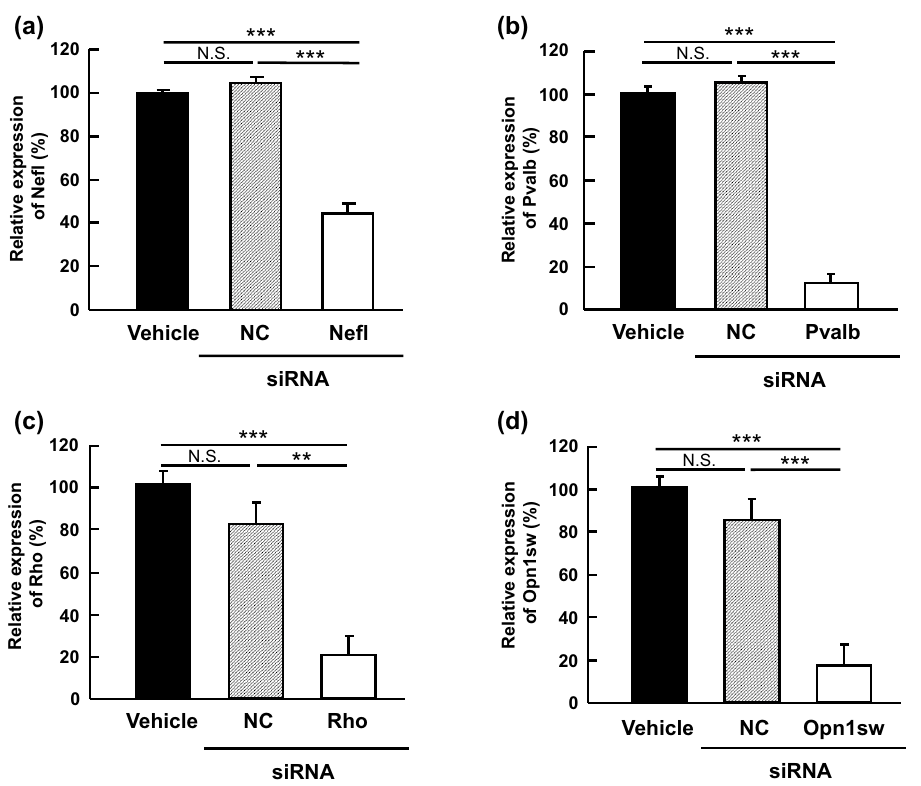
Figure 2. Gene silencing following intravitreal injection of Accell siRNA targeting four retinal cell type-specific genes in the rat retina. Expression of cell type-specific genes was measured 3 ( Pvalb , Rho and Opn1sw ) or 4 days ( Nefl ) after intravitreal injection of vehicle (closed column) or negative control (4 nmol/eye, NC, gray column), or siRNAs targeting cell type-specific genes (4 nmol/eye, open column), as determined by quantitative real- time PCR. The expression values of cell type-specific genes were normalized to that of Gapdh [ Nefl , ( a ); Pvalb , ( b ); Opn1sw , ( d ) or Actb ( Rho , (c ))] and is shown as the percentage of the respective control value in vehicle- treated group. Each value represents the mean ± S.E.M. for n = 4 or 8. ** P < 0.01; *** P < 0.001, by Tukey’s multiple comparison test. N.S. represents not